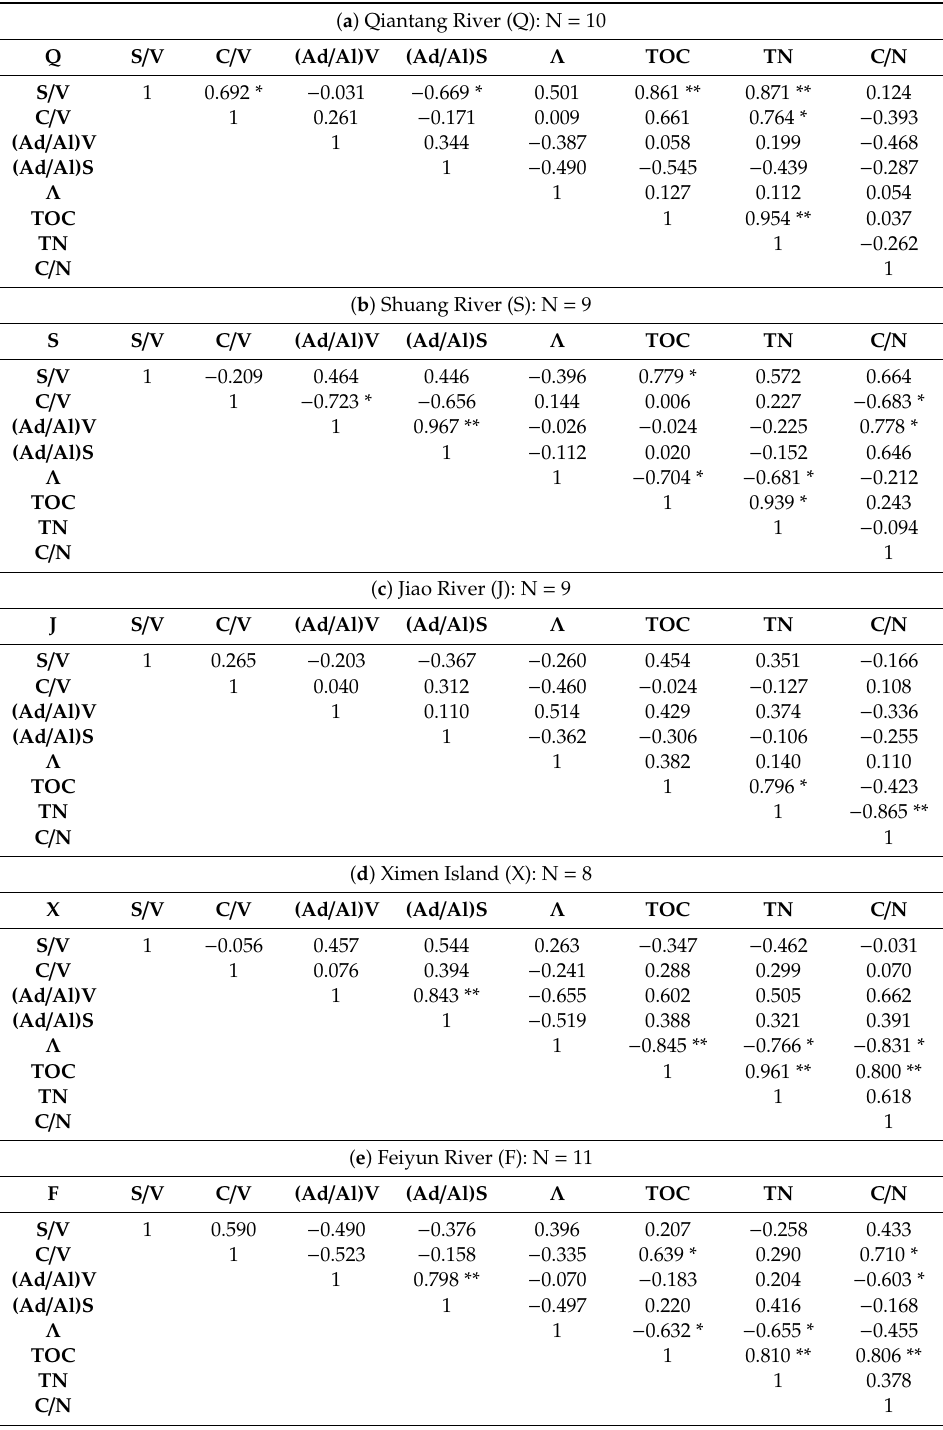
Table A3. Correlation among the lignin parameters. ( a ) Qiantang River (Q): N = 10, ( b ) Shuang River (S): N = 9, ( c ) Jiao River (J): N = 9, ( d ) Ximen Island (X): N = 8, ( e ) Feiyun River (F): N = 11, ( f ) Ao River (A): N =